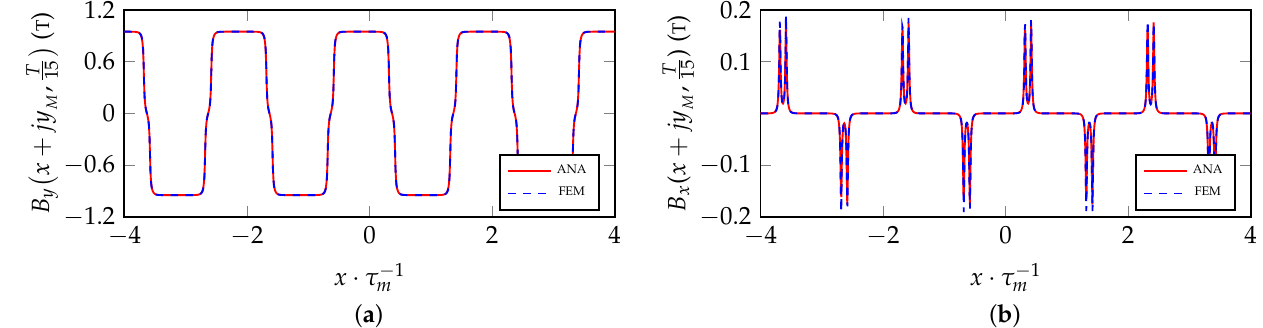
Figure 6. Analytical and FEM no-load flux density distributions on the middle mechanical air-gap line of the slotless machine of Figure 5a, with PM slider position corresponding to a time instant t = T/15 ( 4 τ m 4 τ m N x = 1000). ( a ) normal; ( b ) tangential component. x − ≤ ≤